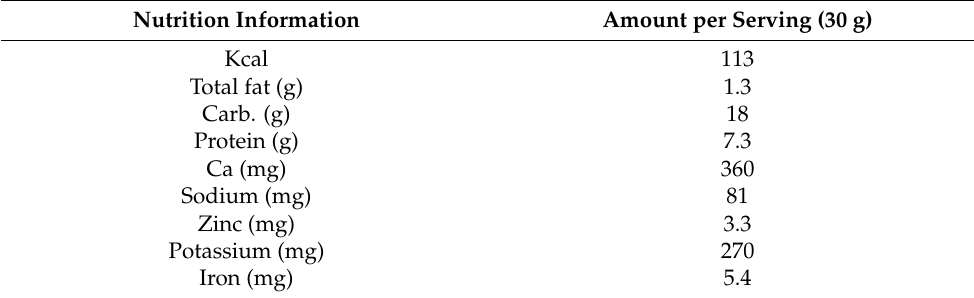
Table 2. Balanced diet composition for SHAM